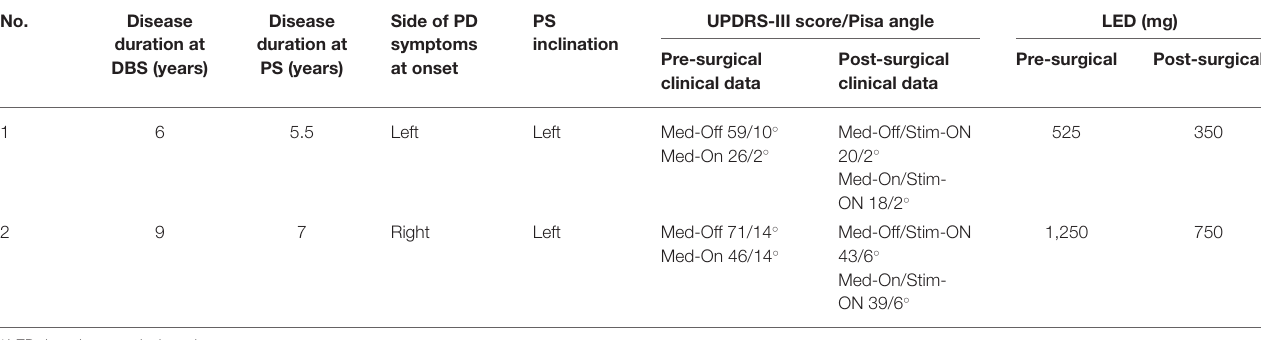
TABLE 1 | Clinical features and outcomes in 2 patients with Pisa syndrome. No.